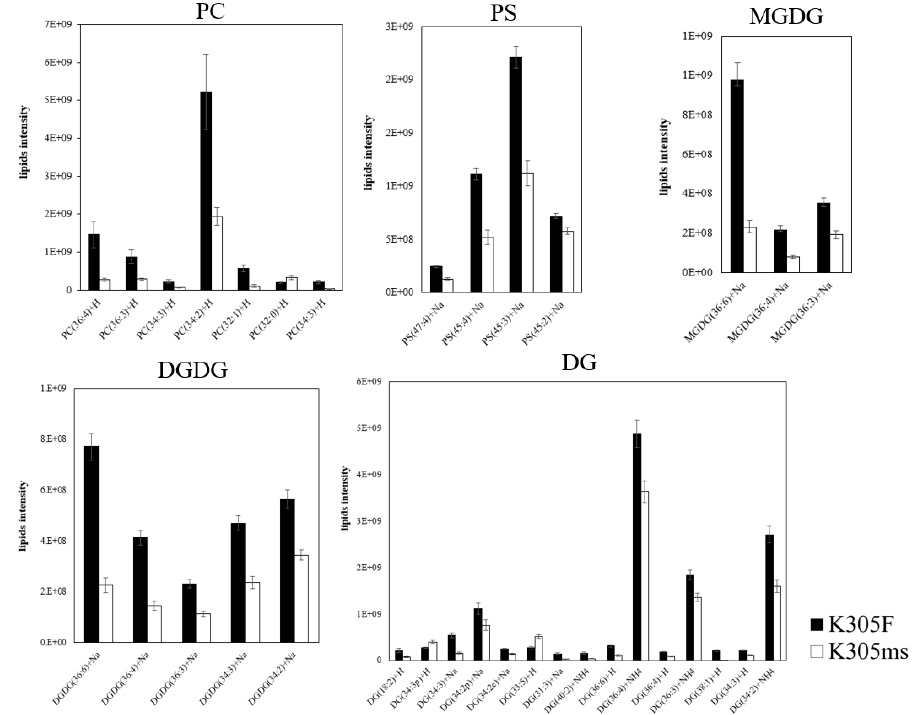
Figure 7. Differentially expressed lipid molecules between ms305 (K305ms) and fertile sibling (K305F) anthers. PC, phosphatidylcholine; PS, phosphatidylserines; MGDG, monogalactosyldiacylglycerols; DGDG, digalactosyldiacylglycerols. Error bars indicate SD ( n =